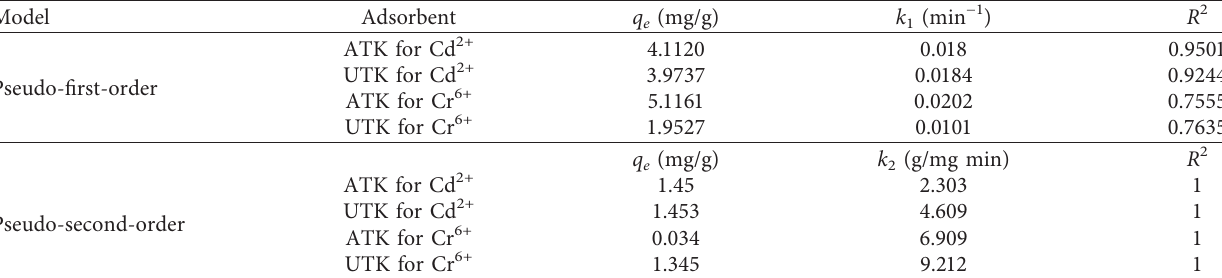
Table 2: Evaluated parameters of pseudo-first-order and pseudo-second-order for Cd (II) and Cr (VI) metal ion biosorption onto ATK and UTK.